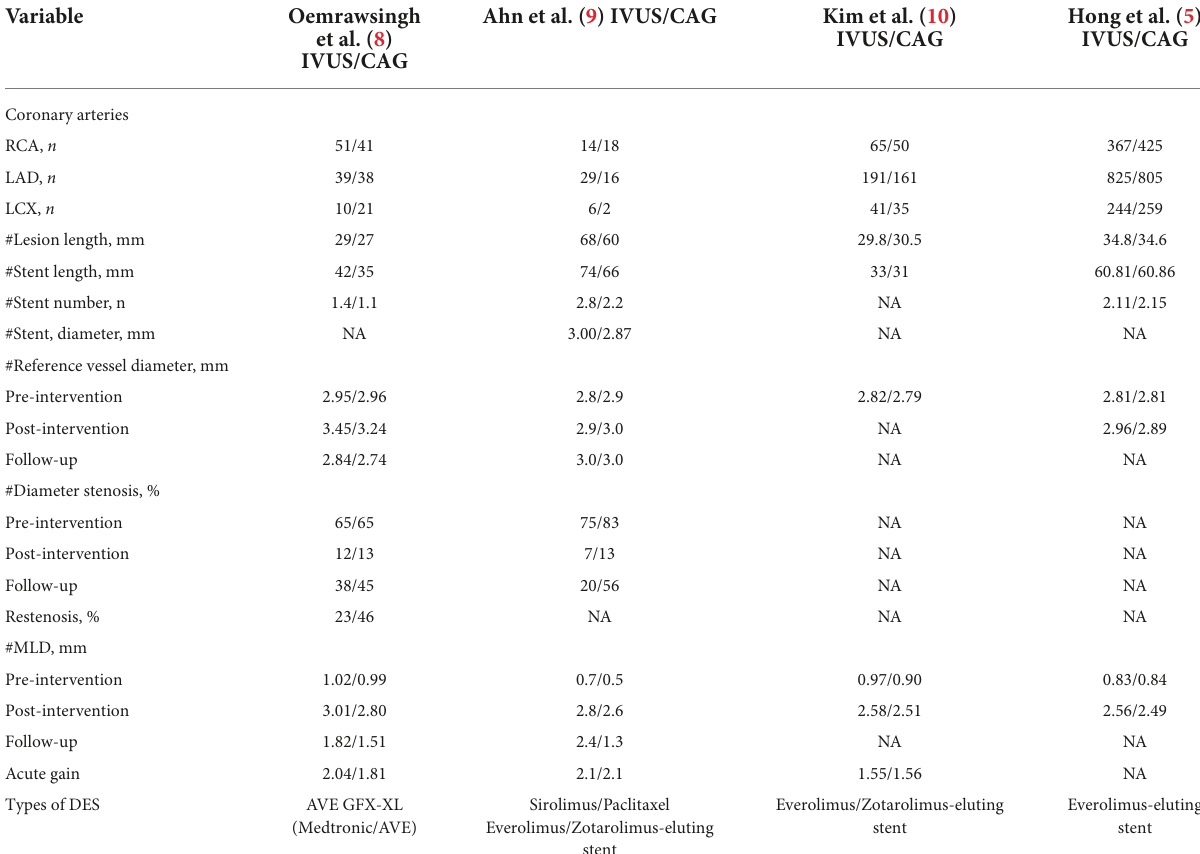
TABLE 2 Procedural